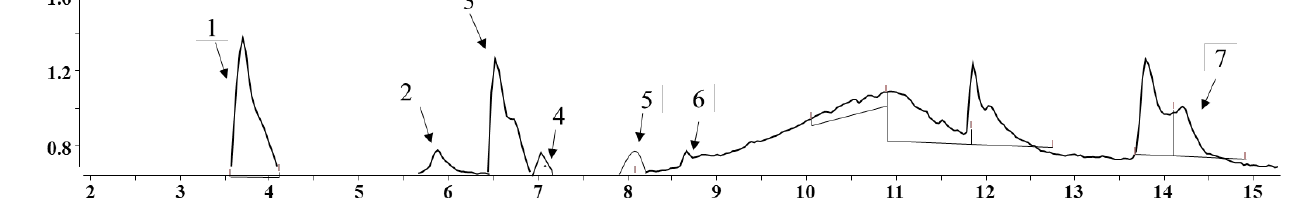
Figure 2. TIC chromatogram of H. fragile extract. 1 : chlorogenic acid; 2 : quercetin 3.4-di-O-glucoside; 3 : rutin; 4 : kaempferol rutinoside; 5 : quercetin; 6 : I3, II8 biapigenin; 7 : hyperforin.